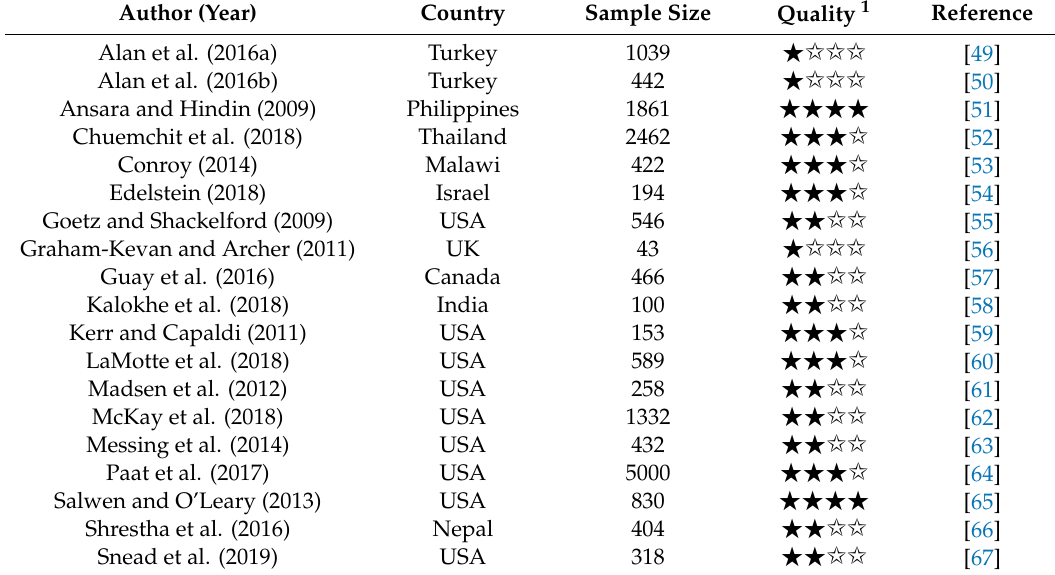
Table 2. Country, sample size and quality assessment of included quantitative